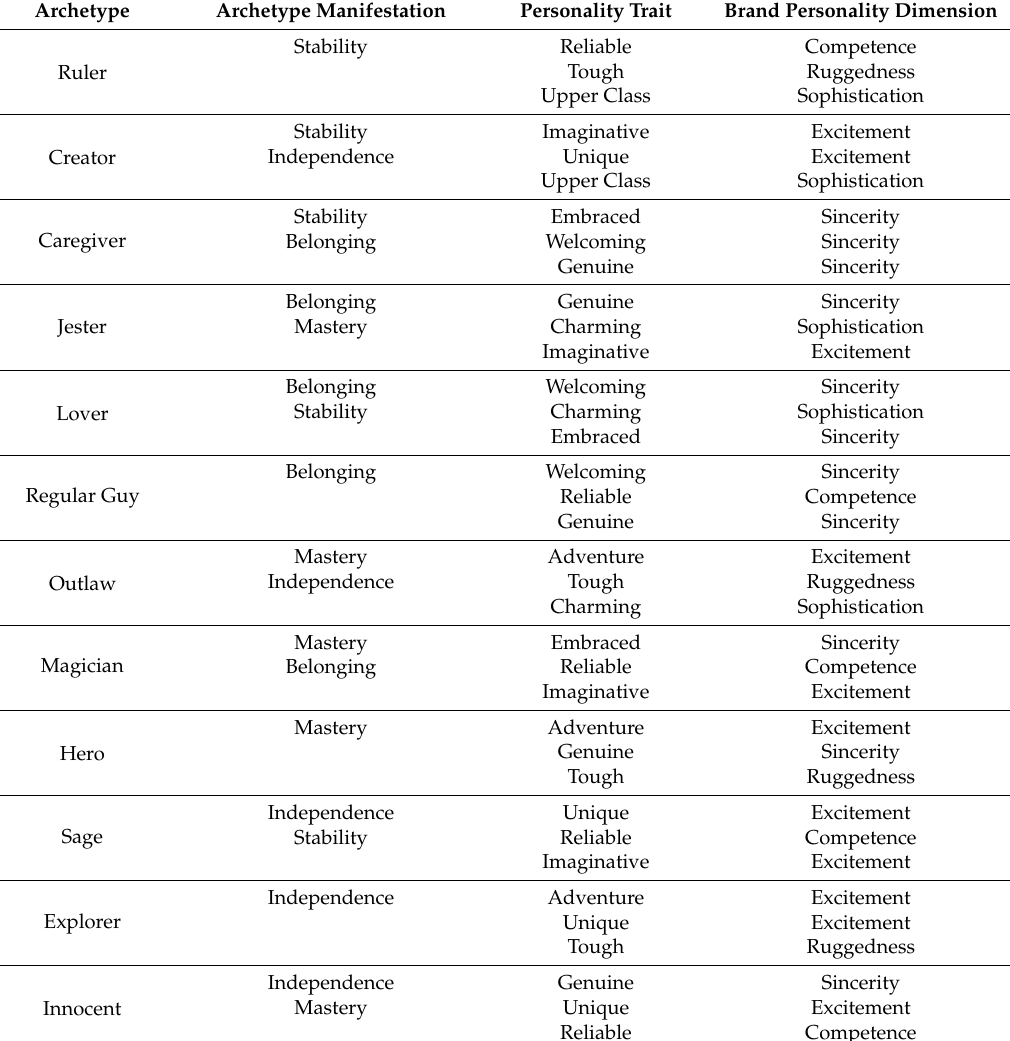
Table 3. Archetypes and brand